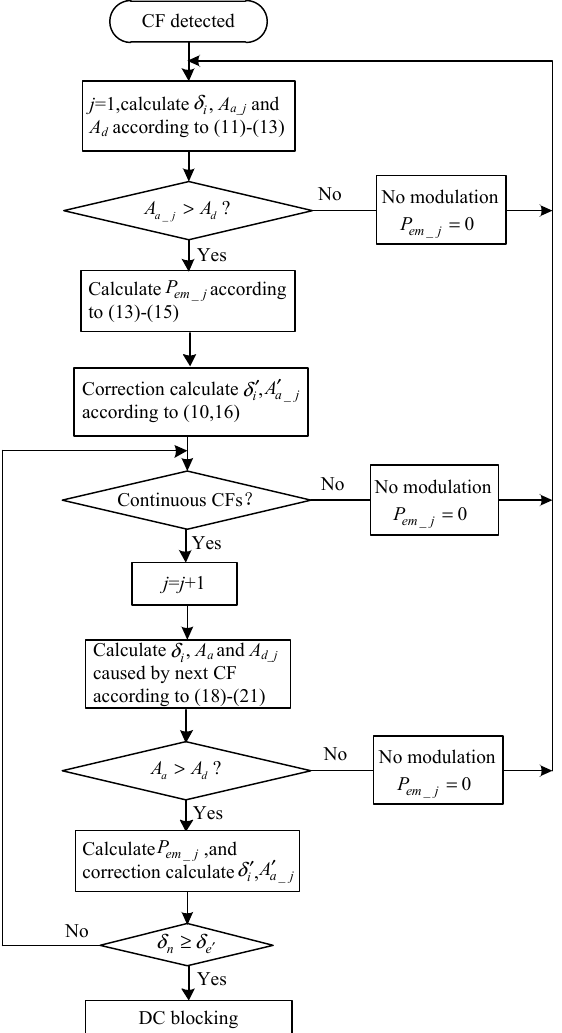
Figure 5. Flow chart of DC emergency power control.